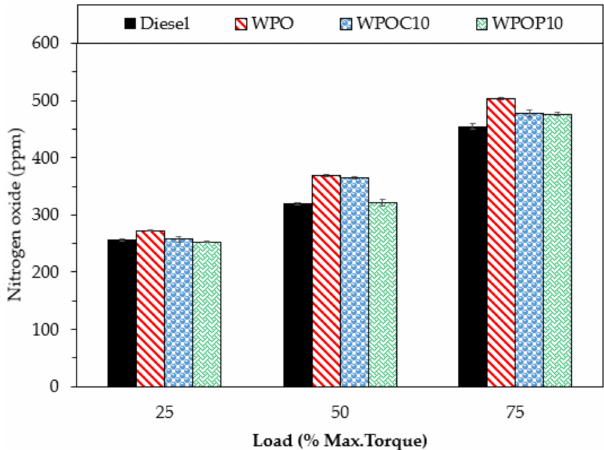
Figure 9. Nitrogen oxide